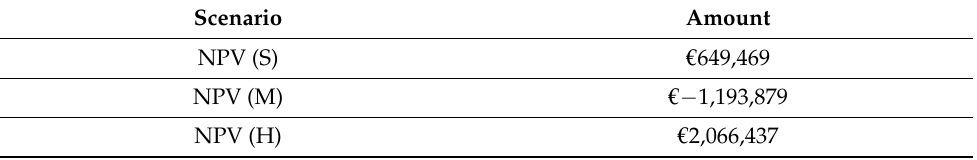
Table 18. Eventual net present values of large battery storage